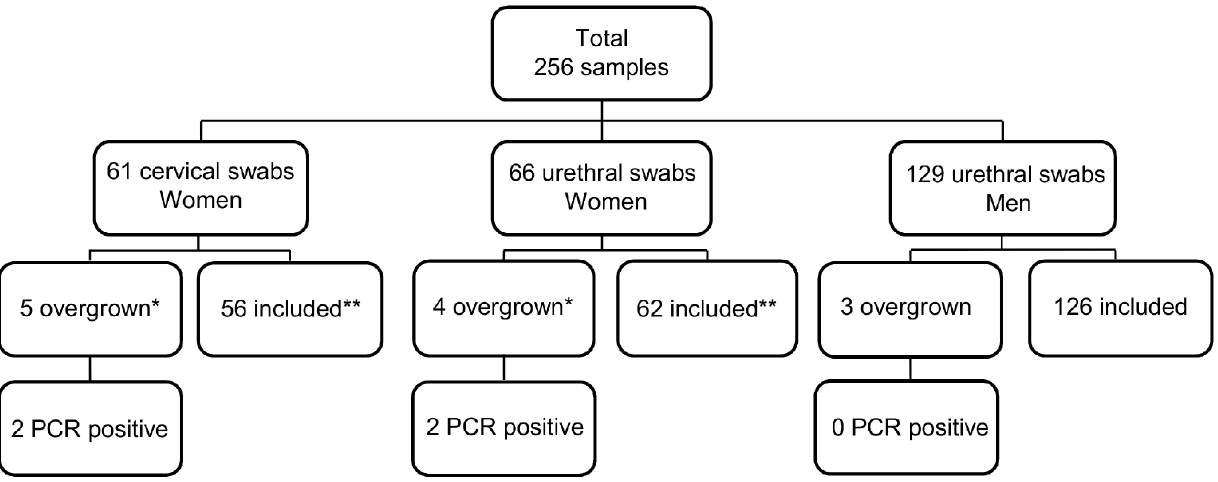
Figure 1. Flow-chart showing the distribution of samples included in the study. * Four had a matching urethral- or cervical swab sample from the same woman which was also overgrown. One excluded cervical swab sample was not overgrown in the matching urethral swab. ** Fifty-five had a paired urethral- or cervical swab sample from the same woman.